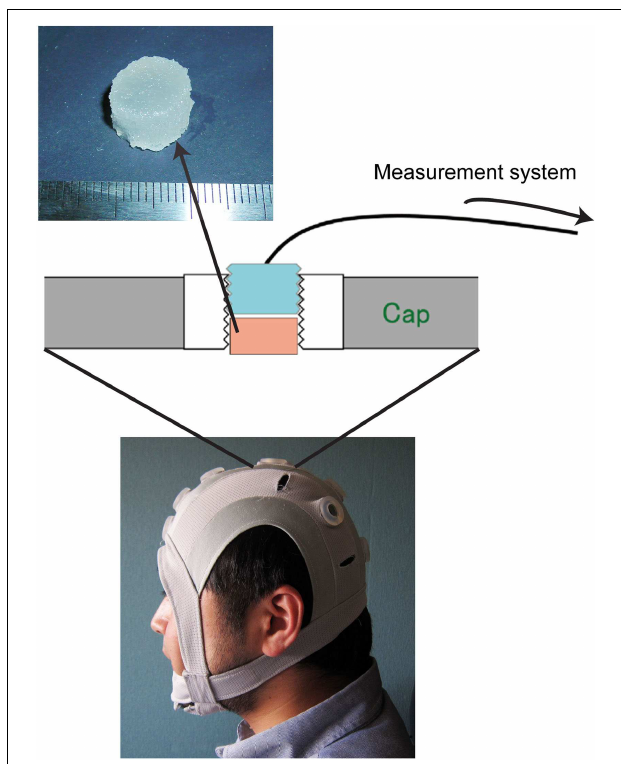
FIGURE 1 | Photograph of the originally developed head-mounted cap, which has 12 electrode sockets. One of the electrode sockets on the cap is enlarged to explain how the solid-gel is used.The solid-gel chip is loaded in the through-hole; the hole is then plugged with an electrode plate.The diameter of the chip was approximately 12mm, and the height was approximately